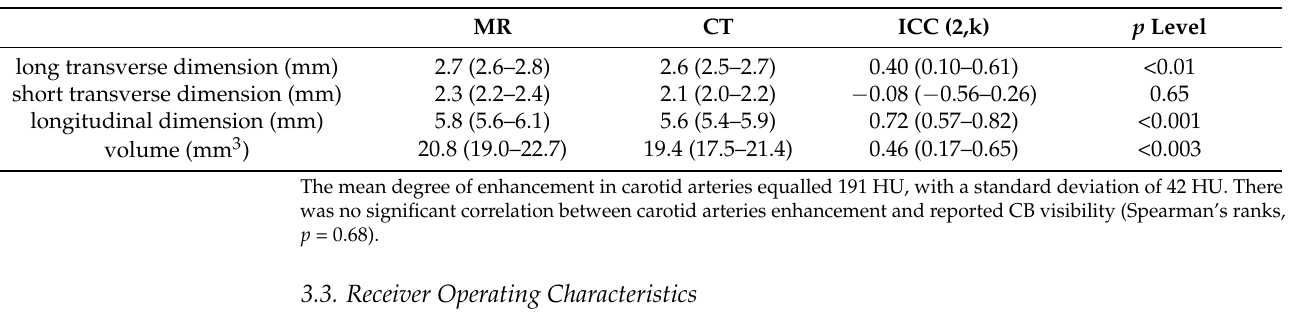
Table 2. Comparison of mean carotid body dimensions (in mm) and volume (in mm 3 ) in magnetic resonance and computed tomography, with 95% CI in brackets.